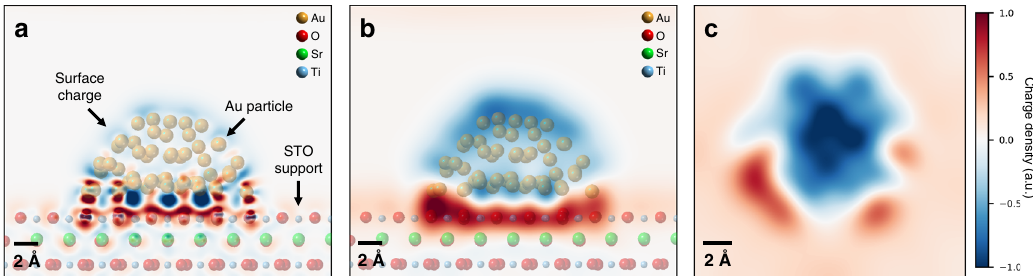
Fig. 3 Charge transfer at a (111)-oriented Au nanoparticle/(001)-oriented STO support interface, calculated by DFT. a Localized regions with high charge transfer are present under a pristine Au particle on an STO support, with Au-O bonds resulting in highly positive features. Data is displayed down the (110) STO zone axis. b The net charge on the particle is negative (blue) and the support is positive (red), as can be seen by averaging over the atomic- scale features of the charge transfer. c A top-down view reveals that, as in the experiments, the particle appears negative in projection, and the surrounding support